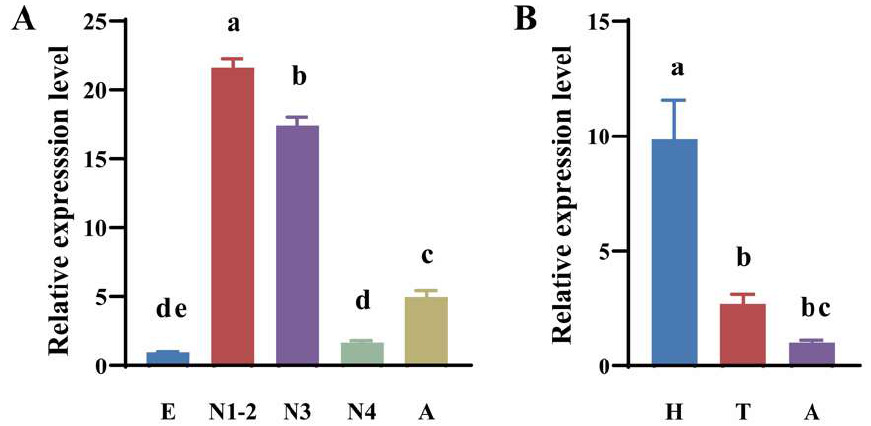
Figure 3. Spatiotemporal expression profiles of CYP4G68 in B. tabaci . ( A ) Developmental stage expression patterns of CYP4G68 in B. tabaci . E: egg; N1–2: 1st and 2nd instar nymph; N3: 3rd instar nymph; N4: 4th instar nymph; A: adult. ( B ) Tissue-specific expression patterns of CYP4G68 in B. tabaci adults. H: head; T: thorax; A: abdomen. Values are means ± SEM ( n = 3), with different lower- case letters above the bars representing significant differences ( p < 0.05).